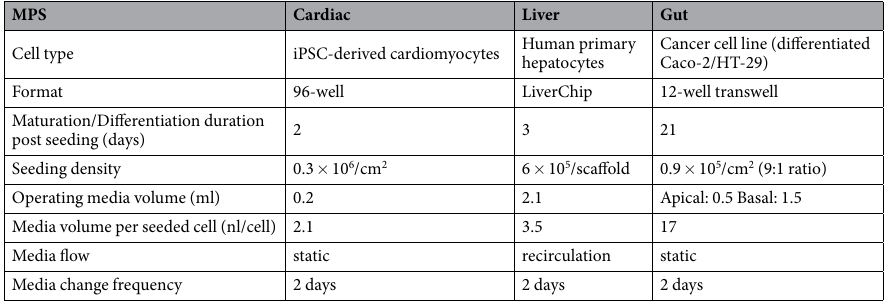
Table 1. Overview of MPS configuration, MPS-specific hardware and cell